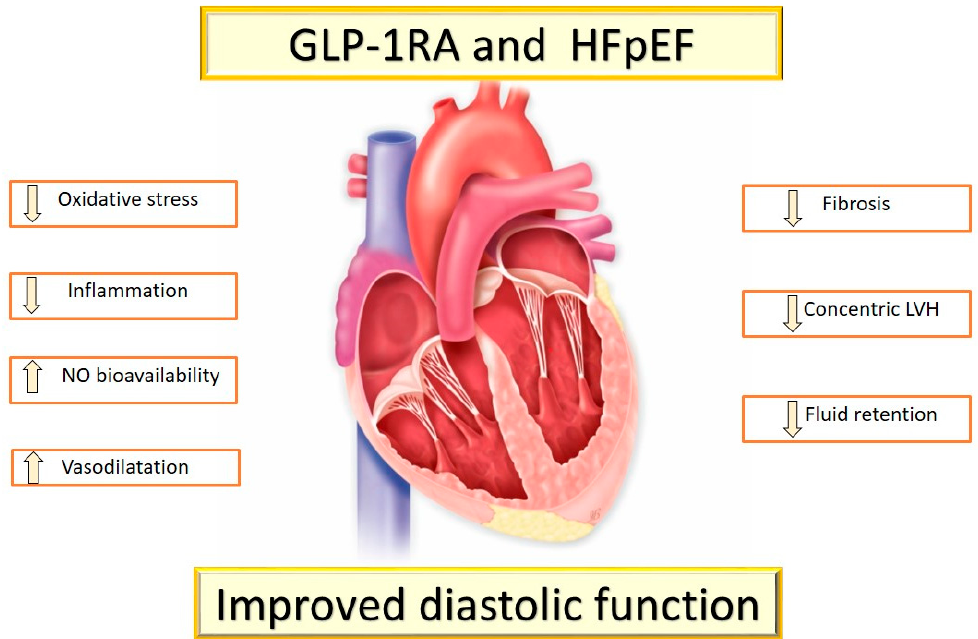
Figure 3. GLP-1 RA and HFpEF. GLP-1 RA improves left ventricular diastolic function.